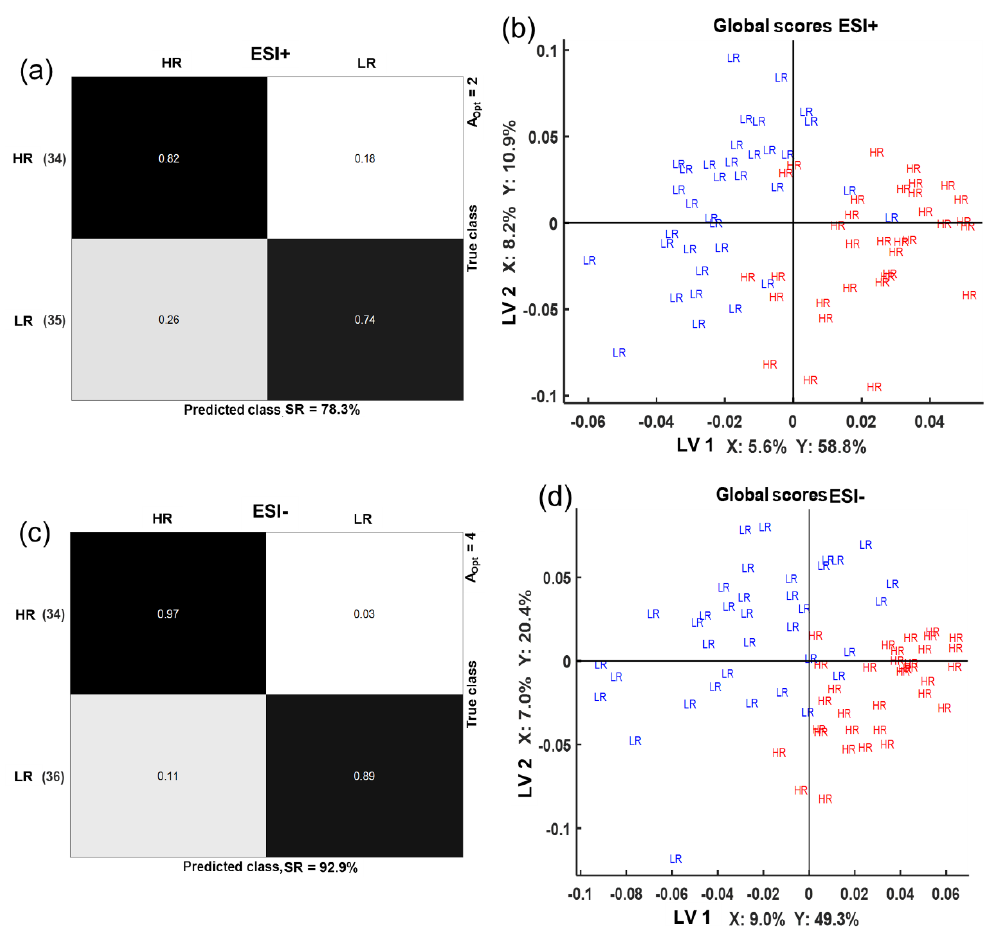
Figure 4. Sparse multi-block partial least squares regression (sMBPLSR) confusion matrices ( a , c ) and global score plots ( b , d ) from classification analysis of HR and LR groups using plasma, urine, and feces metabolomics in positive ( a , b ) and negative ( c , d ) ionization mode. The success rate (SR) of cross-validation is provided together with the number of latent variables of the models (A Opt ). Numbers in parentheses ( a , c ) reflect the number of samples used in the multi-block analysis after a sample-to-sample correspondence. Explained variances (%) in matrices X and Y by the corresponding latent variables (LV) are provided ( b , d ).